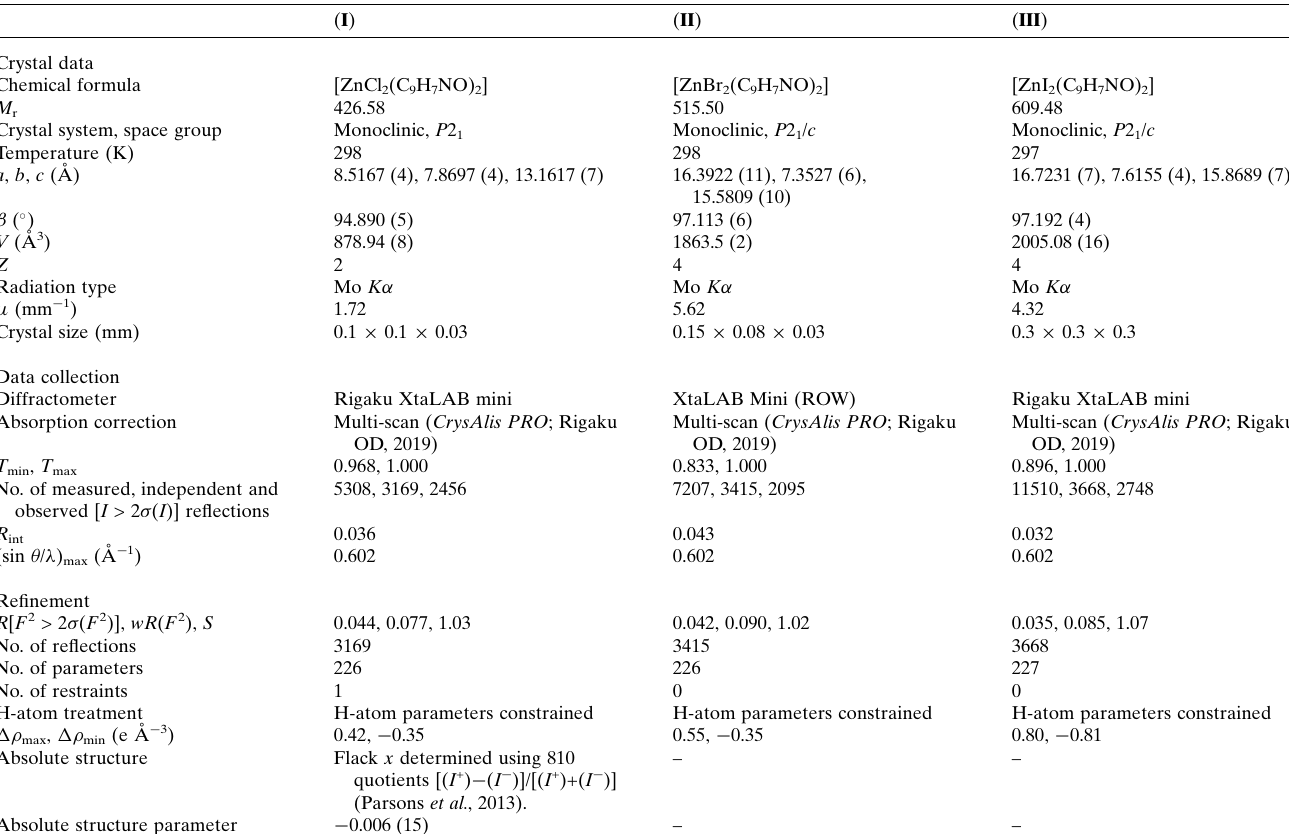
Table 3 Experimental details.